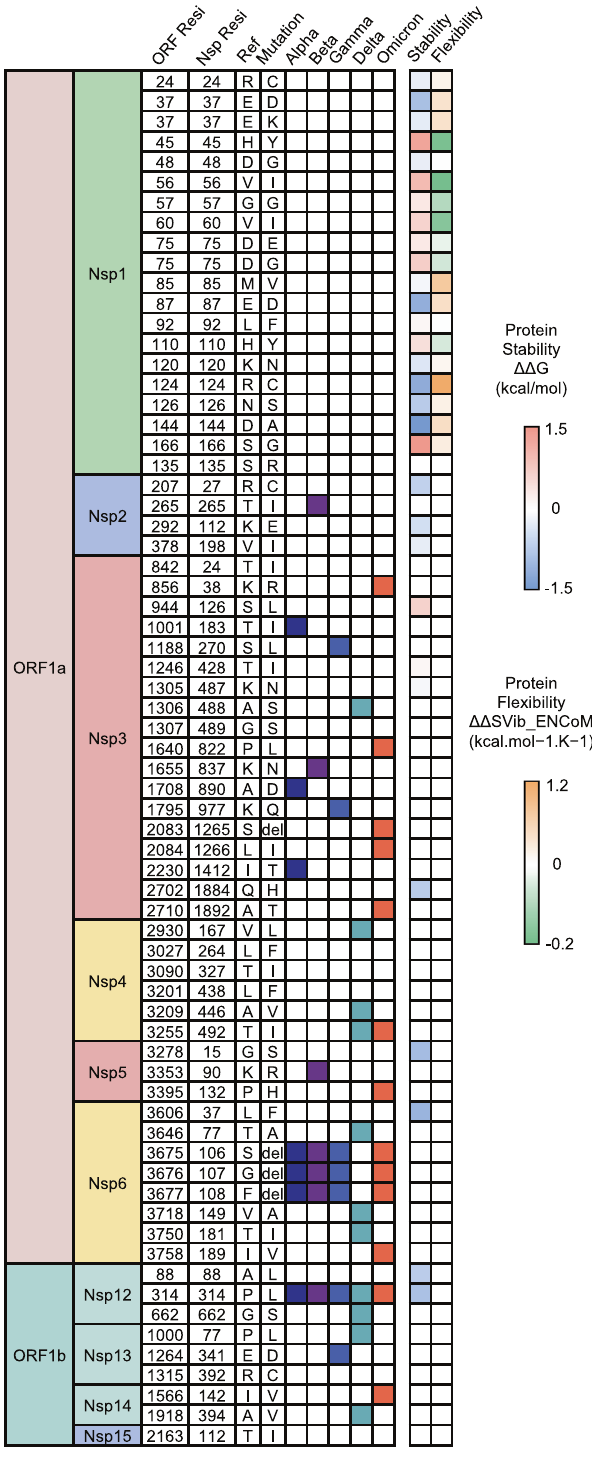
Fig. 4 Heatmap of the mutation site and the mutational impact of SARS-CoV-2 variants on the non-structural proteins. The mutation site and its wild type and mutant residue in ORF sequence and detailed non-structural protein sequence among all variants are displayed. Each mutation is marked in a different color in the representation of the occurrence in VOCs and color-scale in re fl ection of the impact on protein stability and fl exibility. Details for each mutation can be found in Supplementary Table